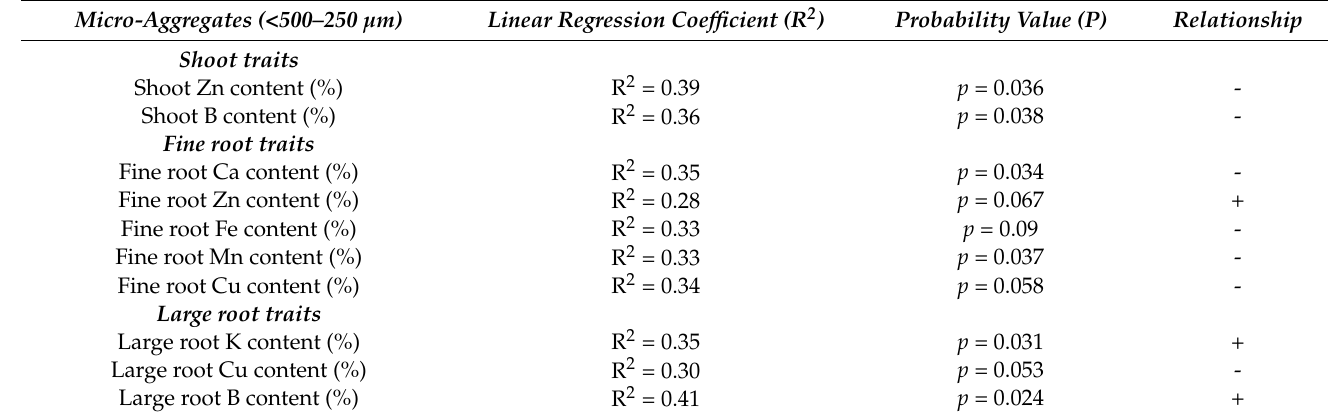
Table 4. Relationship between abundance of microaggregates (<250 µ m) and plant